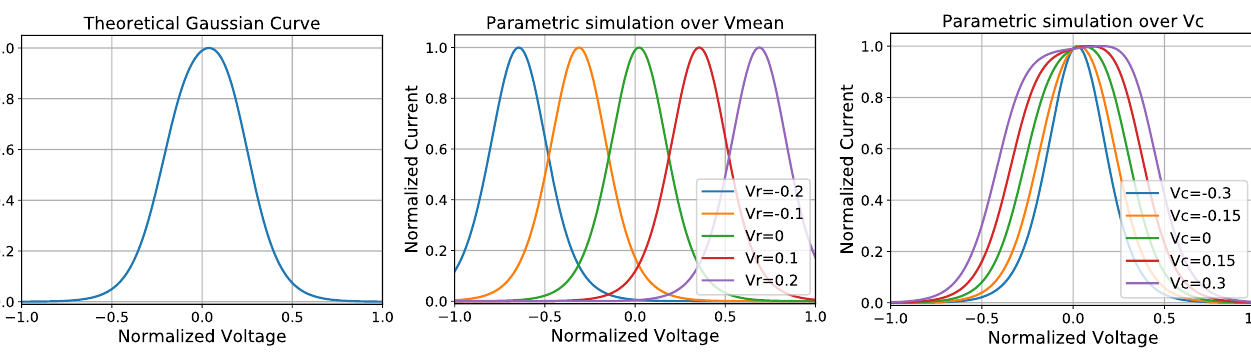
Figure 18. Theoretical output function of an example of a bulk-controlled circuit ( left ) Simulation for V r = 0 and V c = − 0.1 ( center ) Parametric simulation over V r for V c = − 0.3 ( right ) Parametric simulation over V c for V r =